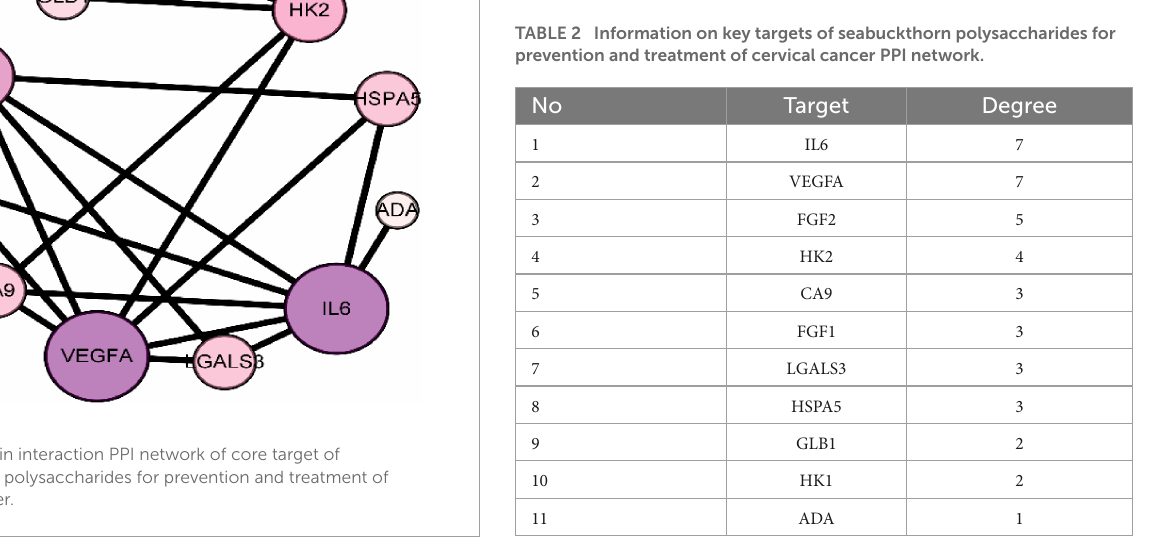
The Swisstarget database was retrieved, and a total of 203 targets were obtained. The same targets were de-processed, and 61 targets were finally selected, mainly including ADORA1, ADORA2A, Adora3, ADA, etc. “Cervical Cancer” as keywords retrieval Gene Cards (see text footnote 1) database, access to Cervical Cancer related target genes, 7819, A total of 2,727 cervical cancer-related disease targets with correlation score greater than 5 were screened, and the Venn diagram of the target of seabuckthorn polysaccharides and the target of cervical cancer was drawn. The results were shown in Figure 1 , and 15 core anti-cervical cancer targets of seabuckthorn polysaccharides were obtained. The results showed that seabuckthorn